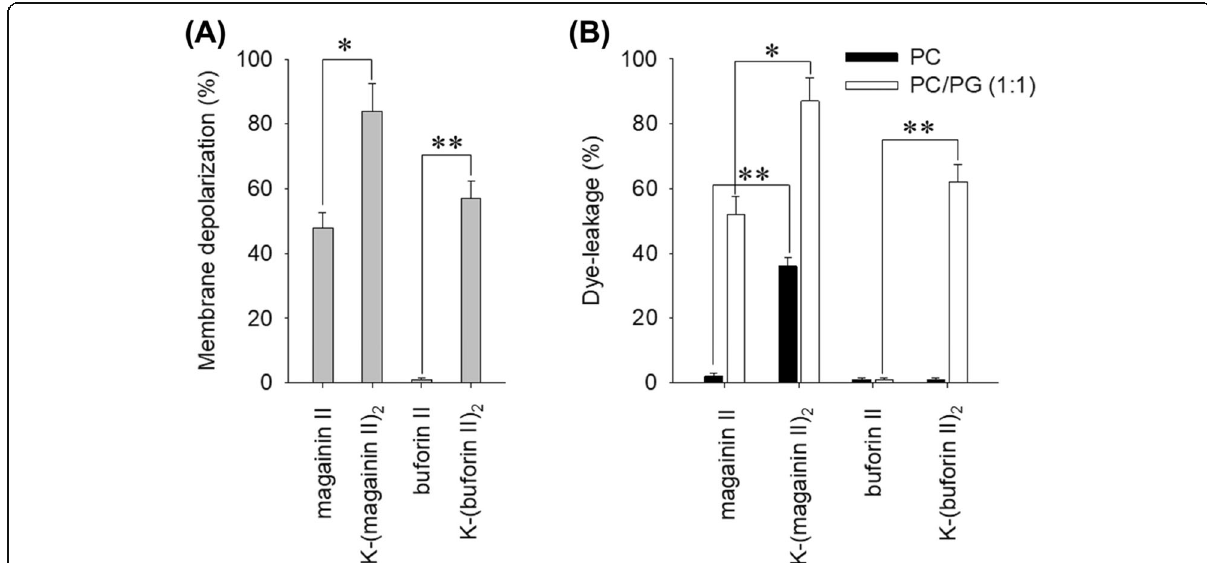
Fig. 2 Ability of peptides to permeabilize membranes. a Effect of peptides on membrane potential of intact S. aureus cells (OD600 = 0.05). After the fluorescence of DiSC3(5) was stabilized, the peptides (2 μ M) were added to S. aureus . b Release of calcein fluorescent probe from anionic PC/ PG (1:1) or zwitterionic PC vesicles. Membrane-lytic activity of peptides was defined as the percent leakage from 100 μ M lipid after 10 min incubation with peptides (2 μ M for PC/PG (1:1) and 20 μ M for PC vesicles). Average ± SD for three independent experiments. Statistically significant ( p < 0.05) and very significant ( p < 0.01) differences are represented by (*) and (**), respectively